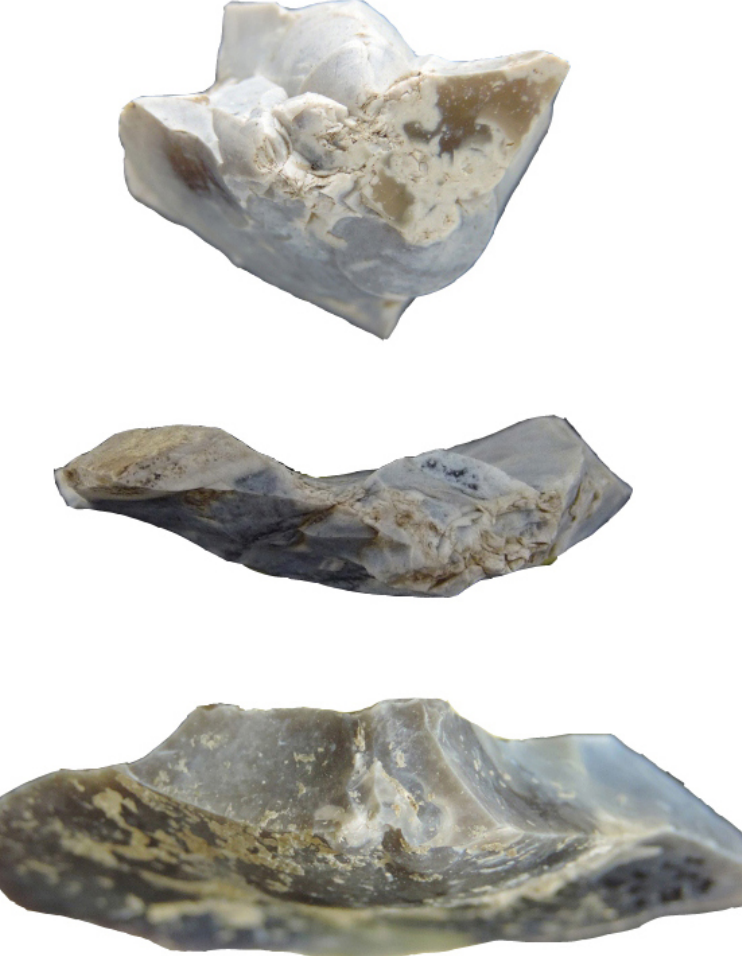
Figure 8. Exemple de talons défigurés du site de Saint-Pierre-d’Autils « Le Plaquis », Porte-Joie « La Couture aux Rois-zone C » et Aubevoye « La Chartreuse » (Eure). Figure 8. Disfigured butt example from Saint-Pierre-d'Autils site. “Le Plaquis”, Porte-Joie “La Couture aux Rois-zone C” and Aubevoye “La Chartreuse”